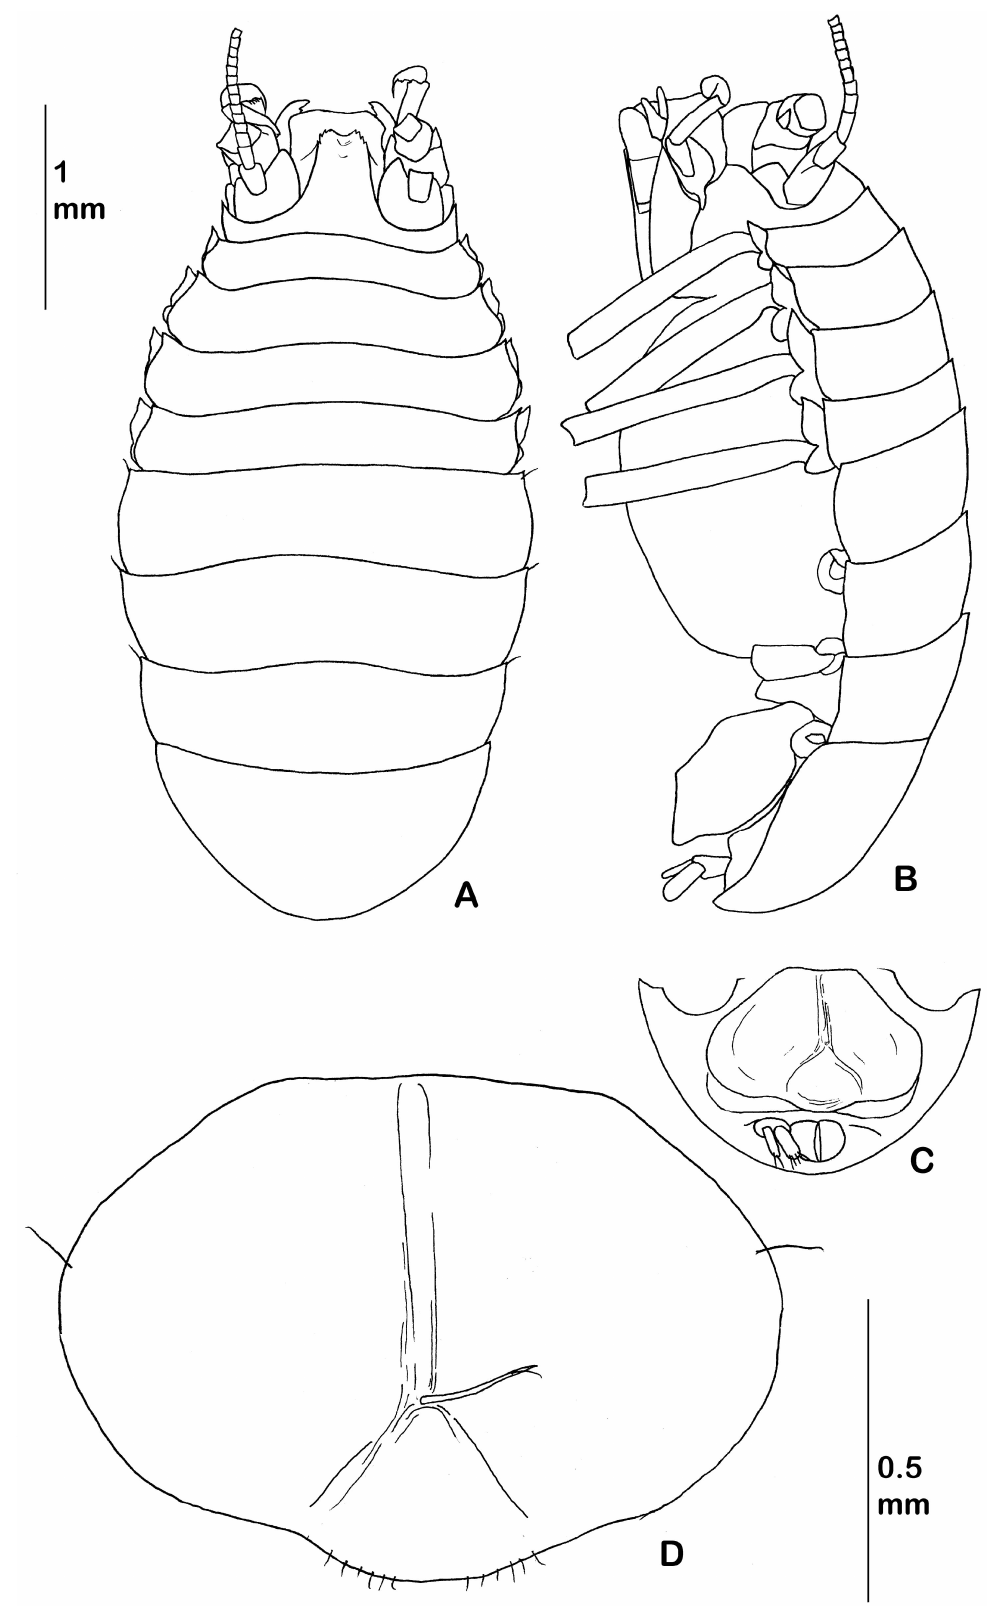
Figure 21. Eurycope nikitai sp. nov. Female paratype (ZMH K-45629): ( A ) dorsal view; ( B ) lateral view; ( C ) pleotelson, ventral view; ( D ) pleopod